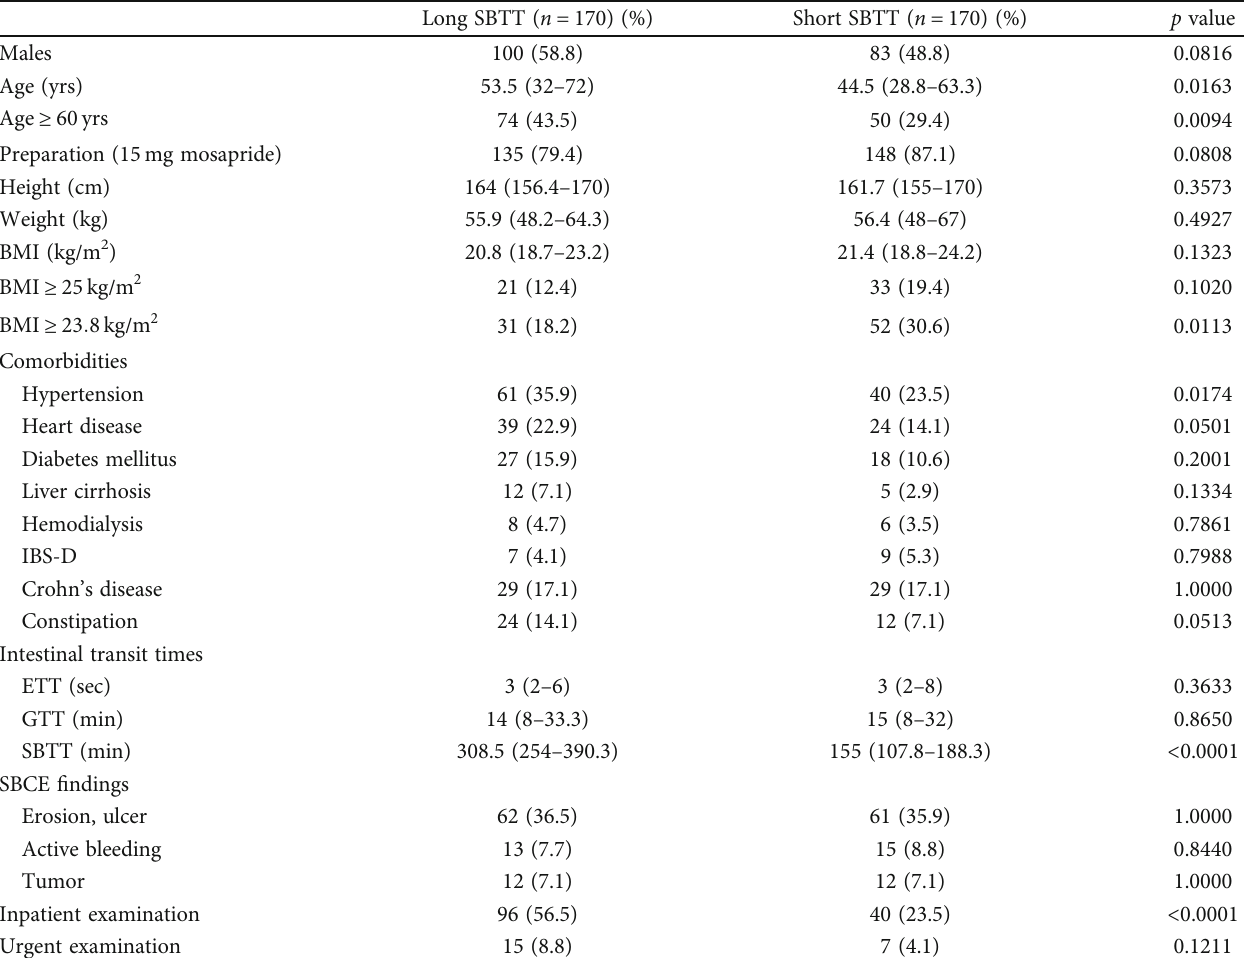
Table 3: Background factors and intestinal transit time grouped by small intestinal transit